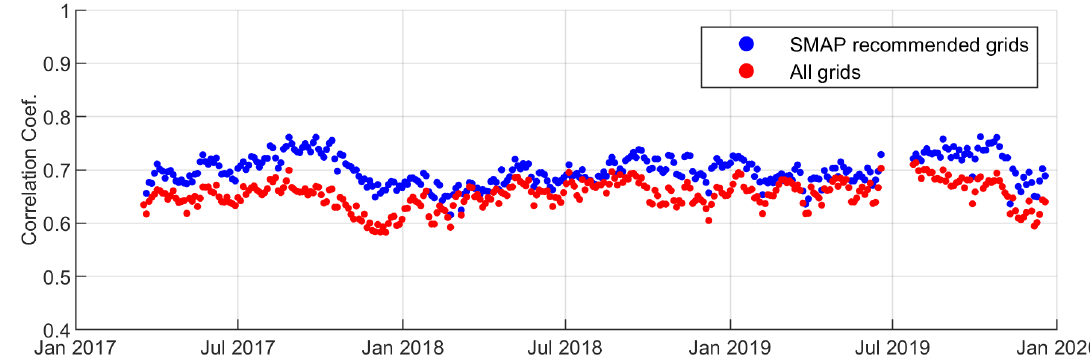
Figure 6. Temporal evaluation of the spatial correlation between CYGNSS-based model prediction and SMAP retrievals for all grids (red circles) and SMAP recommended grids (blue circles).